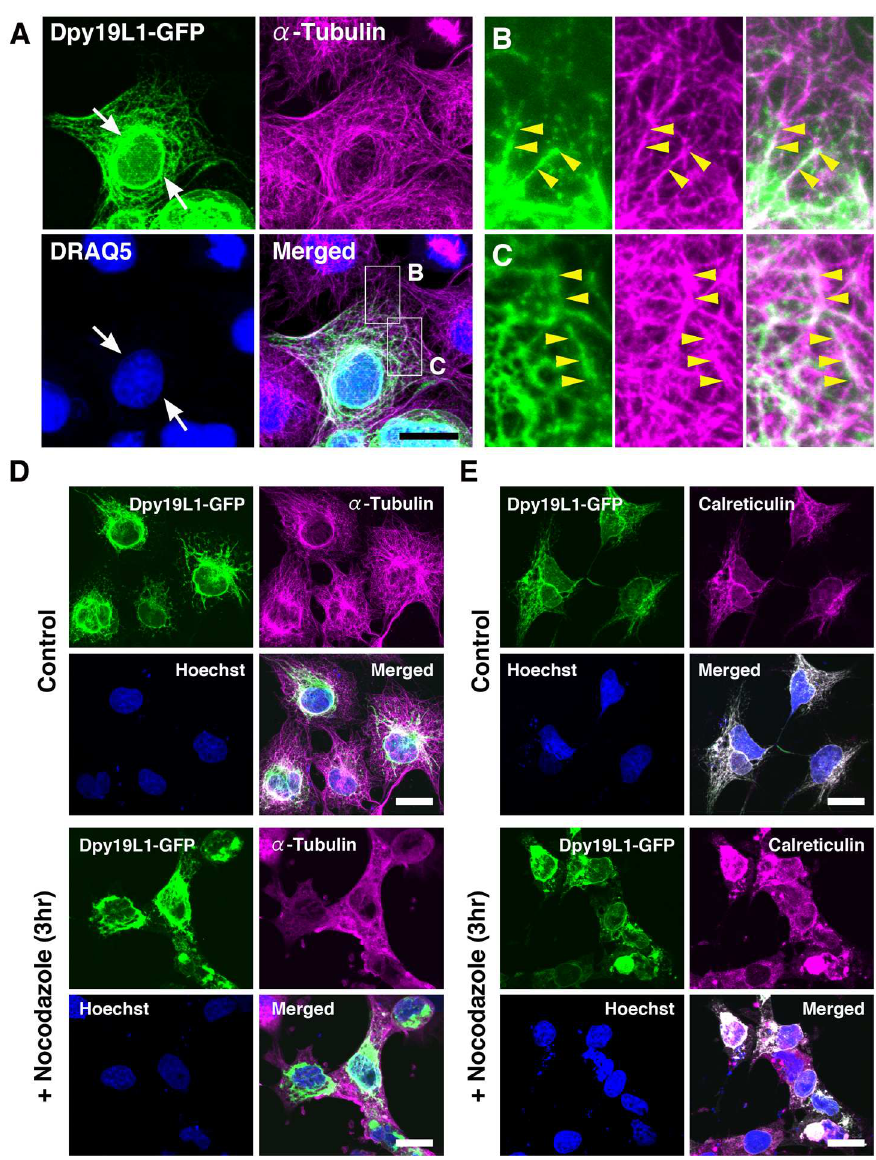
Fig 2. Distribution patterns of Dpy19L1 along microtubules in COS-7 cells. (A-C) Doublestaining of Dpy19L1-GFP (green)and endogenous α -Tubulin(magenta) in COS-7 cells transfected with Dpy19L1-GFP. Nucleuswas labeledby DRAQ5 (blue). Lower right panel shows the merged image. Boxed areas are magnifiedin B and C. Dpy19L1is highly localizedin a perinuclearregion(arrows). The meshwork-likepattern of Dpy19L1 along the microtubule network is observed(yellow arrowheads). (D,E) COS-7 cells transfected with a pDpy19L1-GFP plasmidwere treated by nocodazole, an inhibitorof microtubule assembly, for 3 h before fixation. (D) Immunostaining of GFP and α -Tubulin. (E) Immunostaining of GFP and Calreticulin. The cytoplasmic reticular stainingof Dpy19L1is severely disrupted by application of nocodazole. Nucleus was labeledby Hoechst 33342 (blue). Results shown here were obtainedfrom at least three independentculture experiments. Scale bars: 20 μ